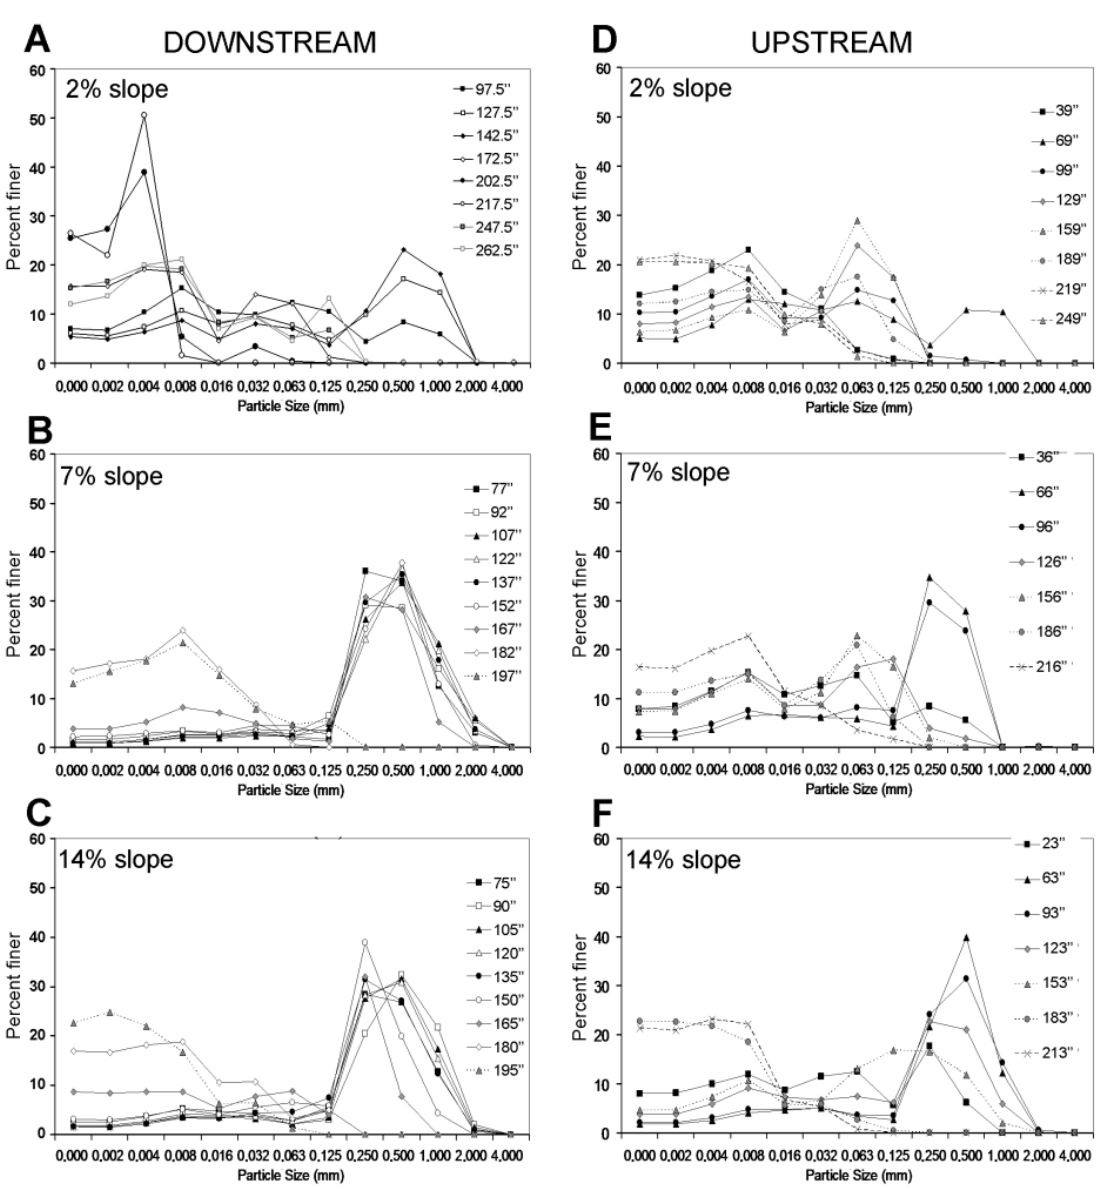
Fig. 3. Evolution in time (seconds) of grain-size distribution curves of sediments transported by overland flow obtained for storms moving downstream (left) and upstream (right) over surface gradients of 2%, 7%, and 14%. Each curve represents mean values from 4 experimental runs.